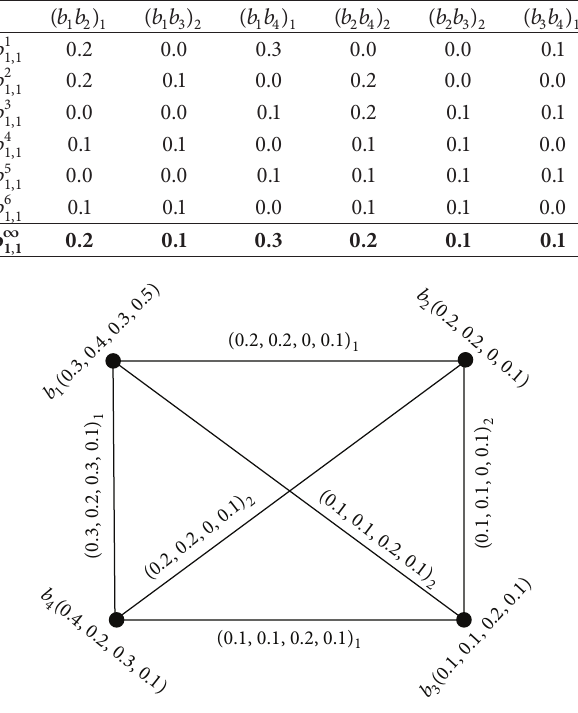
Figure 3: A strong 4-polar fuzzy graph